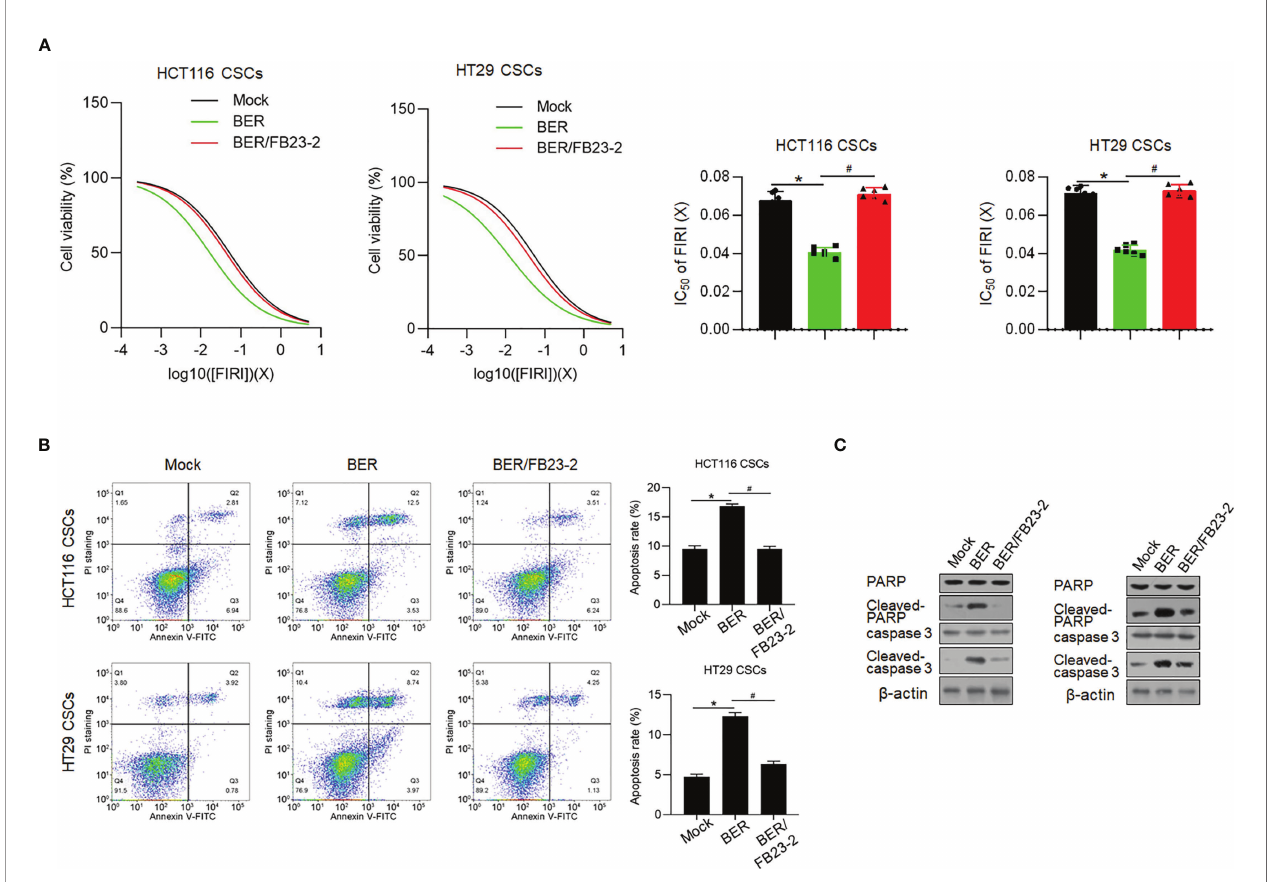
FIGURE 7 | Berberine promoted chemosensitivity. (A) Sulforhodamine B assay was performed to measured the toxicity of FIRI to HCT116 and HT29 CSCs. *p < 0.05, vs. mock group; # p < 0.05, vs. Berberine-treated group. (B) Annexin V-FITC/PI double staining was performed followed by fl ow cytometry to measure the apoptotic rate. *p < 0.05, vs. mock group; # p < 0.05, vs. Berberine-treated group. (C) Western blot was performed to detect apoptosis hallmarkers, cleaved PARP, and cleaved